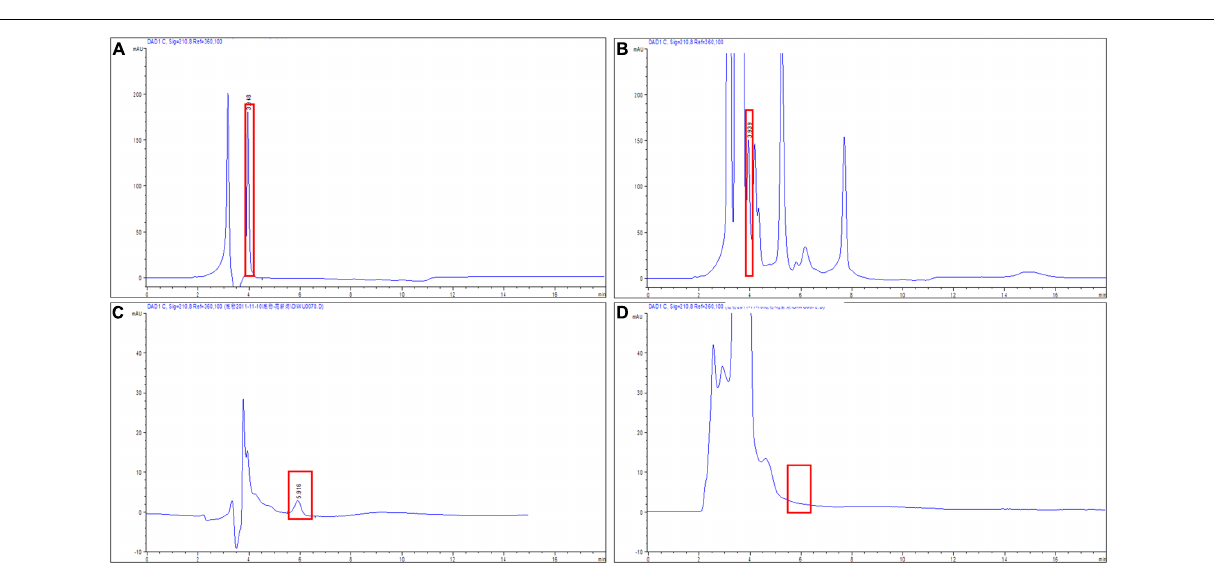
FIGURE 6 | High-performance liquid chromatography analysis (HPLC) analysis of different N -acyl L -homoserine lactones hydrolyzed by Aii810. Chromatography of BHL was hydrolyzed by inactive enzyme (A) and active enzyme (B) , and hydrolysis chromatography of OdDHL by inactive enzyme (C) and active enzyme (D) . Rectangular box indicates the substrates N -acyl L -homoserine lactones before and after